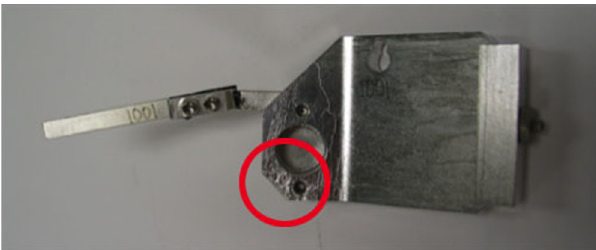
FIG. 5. A used third-generation foil bracket. Melting damage is indicated by the circle. (The figure was reproduced from Ref.